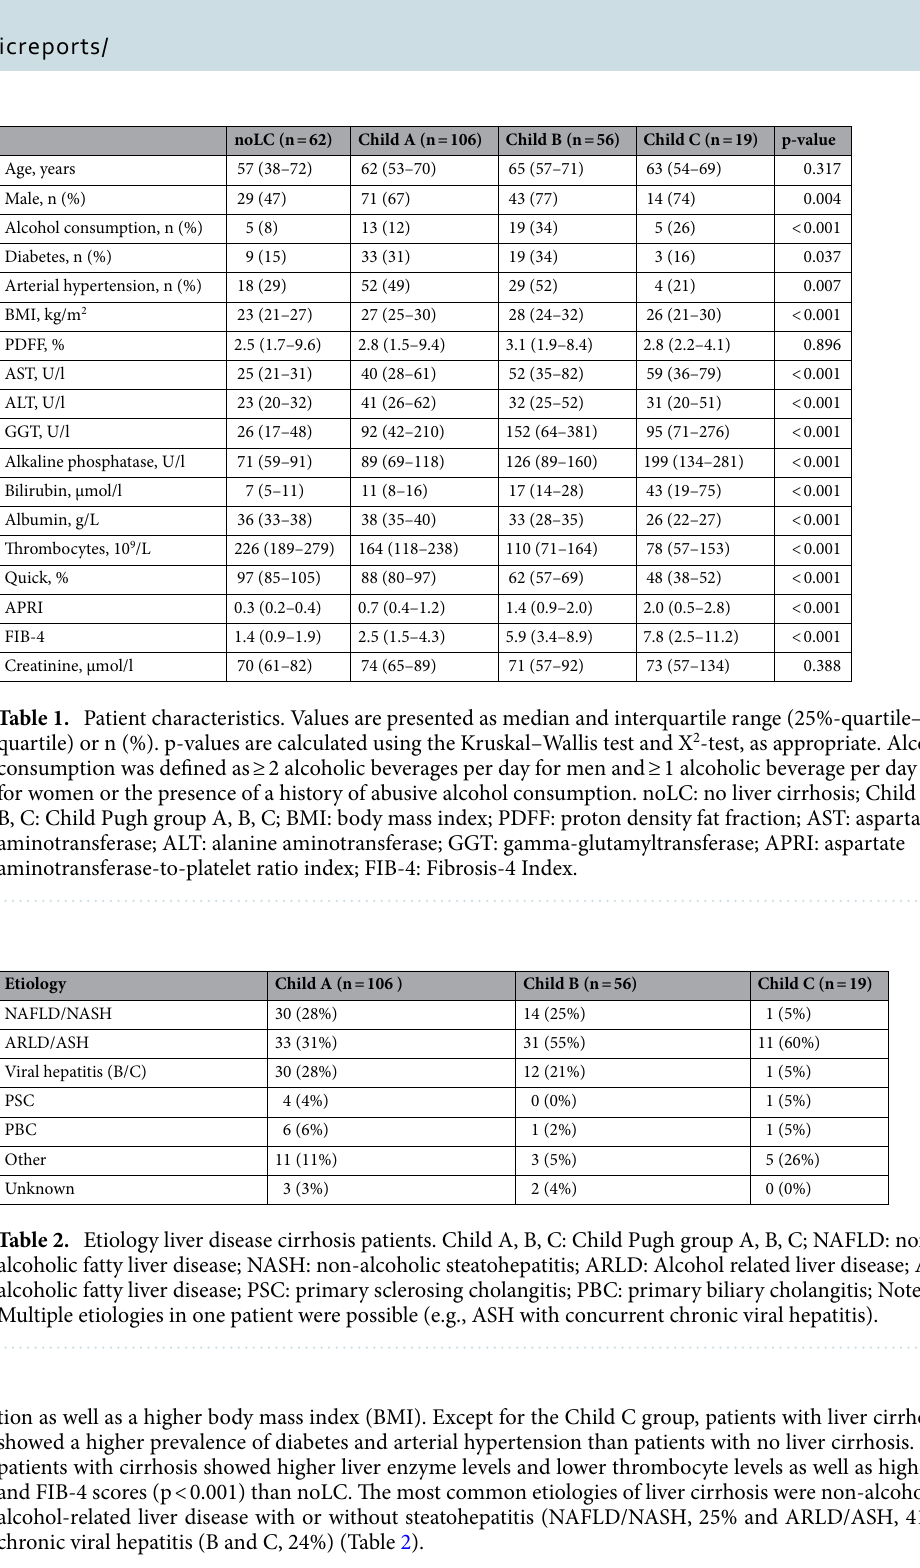
Table 2. Etiology liver disease cirrhosis patients. Child A, B, C: Child Pugh group A, B, C; NAFLD: non- alcoholic fatty liver disease; NASH: non-alcoholic steatohepatitis; ARLD: Alcohol related liver disease; ASH: alcoholic fatty liver disease; PSC: primary sclerosing cholangitis; PBC: primary biliary cholangitis; Note: Multiple etiologies in one patient were possible (e.g., ASH with concurrent chronic viral hepatitis).